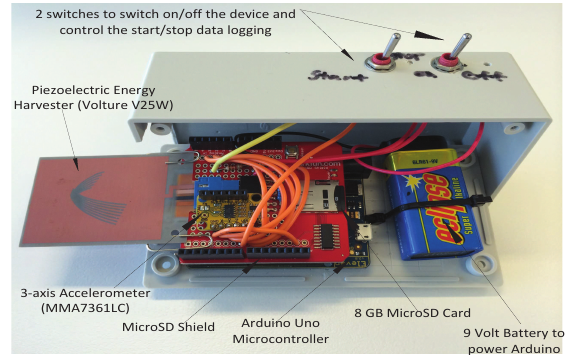
Figure 3: The internal appearance of the data log- ger.